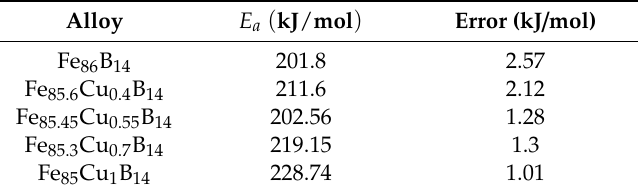
Table 2. The activation energy 𝐸 𝑎 calculated from the T x1 temperatures with errors.